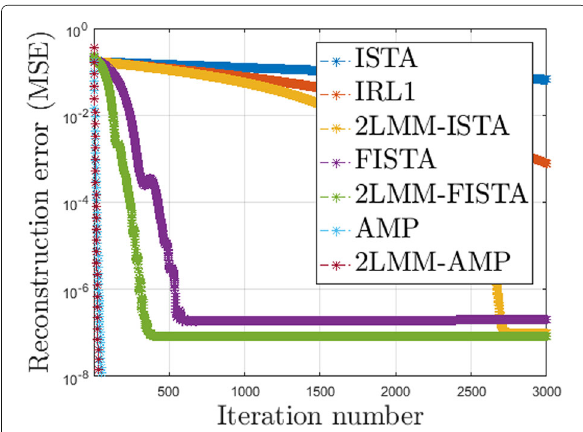
Fig. 5 Convergence rate: evolution of the MSE for classical thresholding method algorithms and the corresponding versions with 2-LMM-tuning for sparse Bernoulli-Gaussian